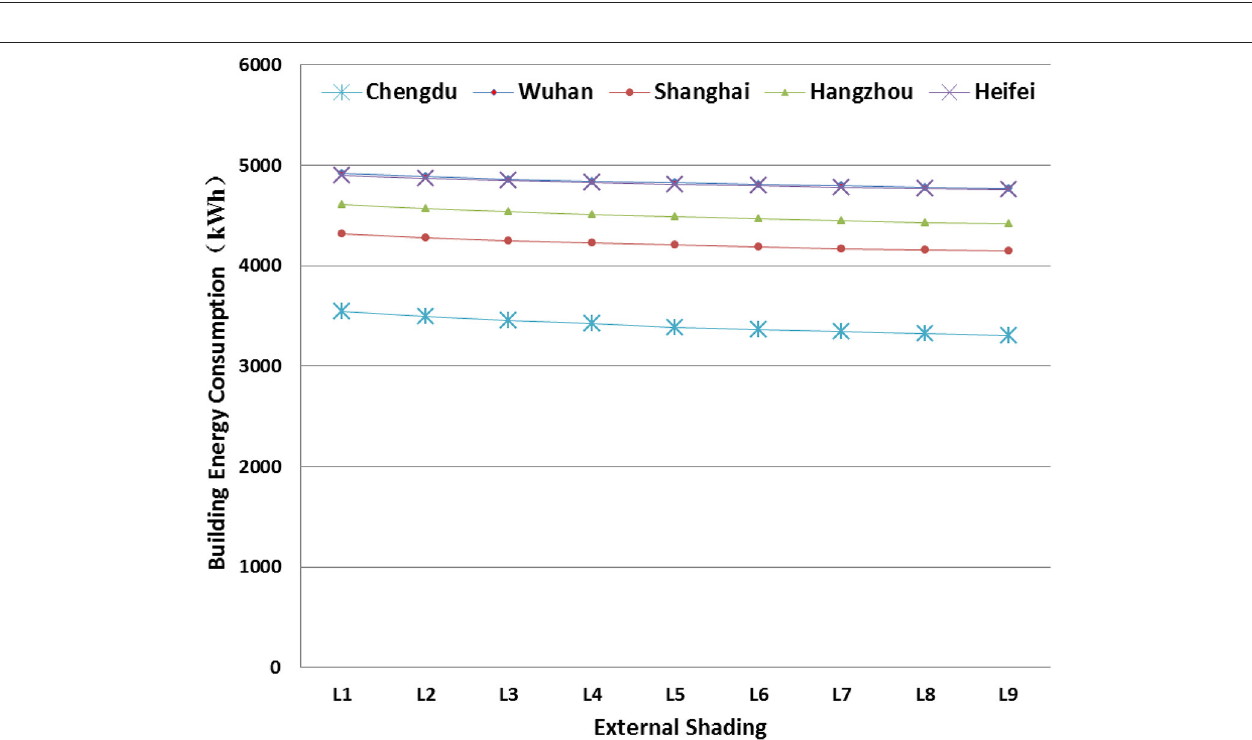
FIGURE 10 | Sensitivity analysis of external window shading on annual energy